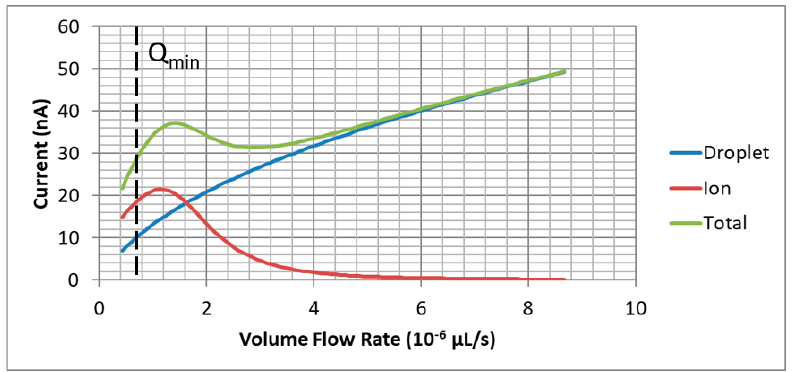
Figure 8. Droplet, ion, and total current versus volume flow rate for system in Figure 7.